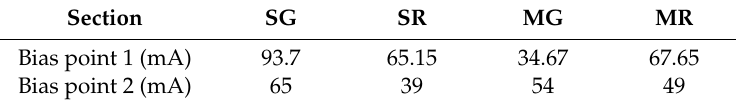
Table 1. Bias points for injection locking spectra.